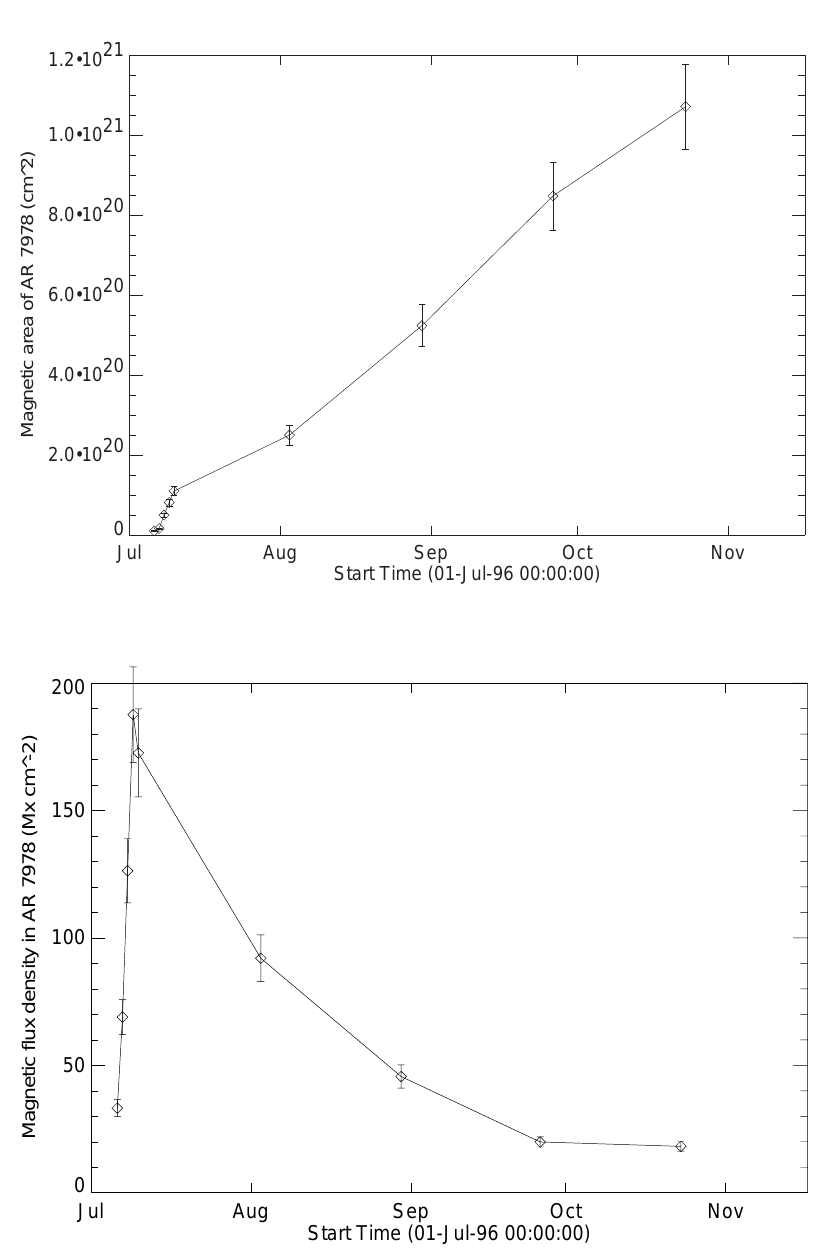
Figure 19: The upper panel shows the magnetic area as a function of time (enclosed by the white contours in Figure 17). The area increased nearly linearly at a rate 1 . 28 × 10 4 km 2 s − 1 . The lower panel shows the evolution of mean magnetic flux density (i.e., total magnetic flux divided by the surface area) of the AR. Images reproduced with permission from van Driel-Gesztelyi et al. (2003b), copyright by AAS; see also van Driel-Gesztelyi et al.